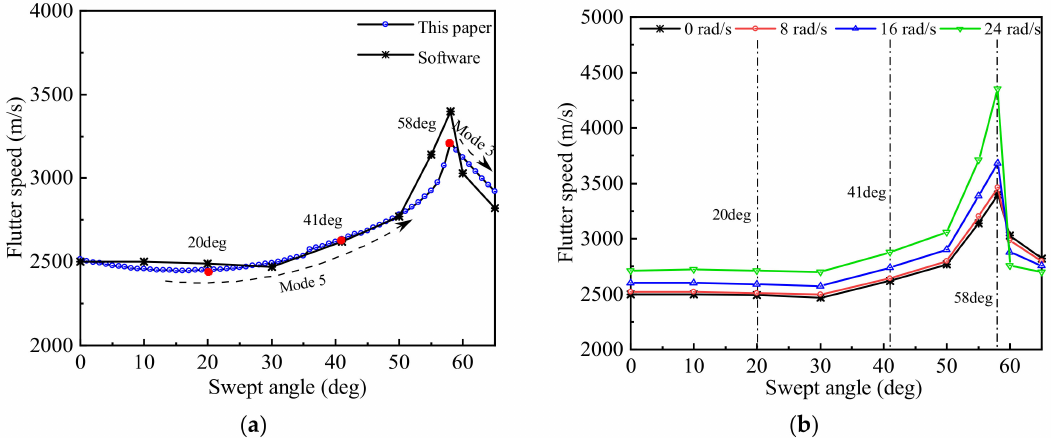
Figure 10. Variations of the flutter speed with the sweep angle. ( a ) This paper vs. software at fixed angle. ( b ) The flutter speed varies with different rotational speeds.